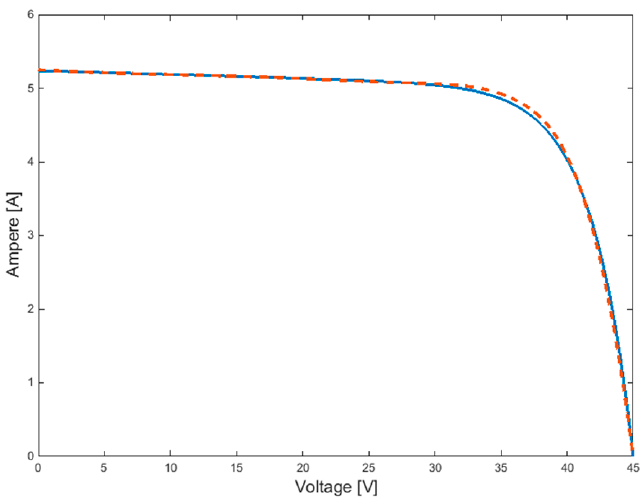
Figure 5 diagrams the results of the “First” simulation: a comparison between the I ‐ V curve (solid blue line) derived from the Equation (12) and the datasheet I ‐ V curve (dotted red line).